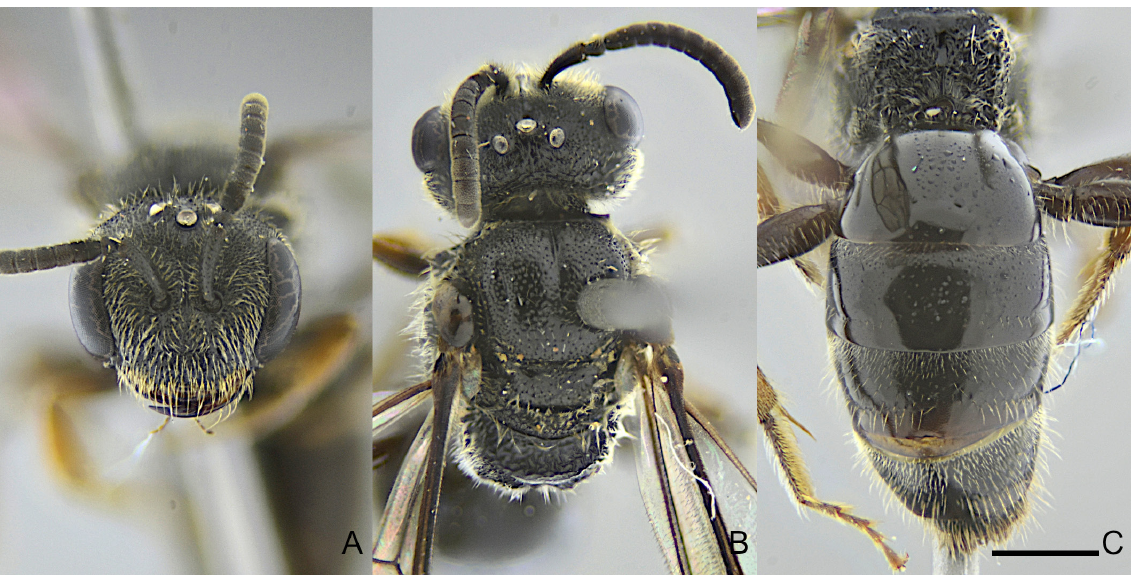
Fig. 9. Austrosphecodes tartarus sp. nov., holotype, ♀ (DZUP 568519). A . Head. B . Mesosoma. C . Propodeum and metasoma. Scale bar = 1